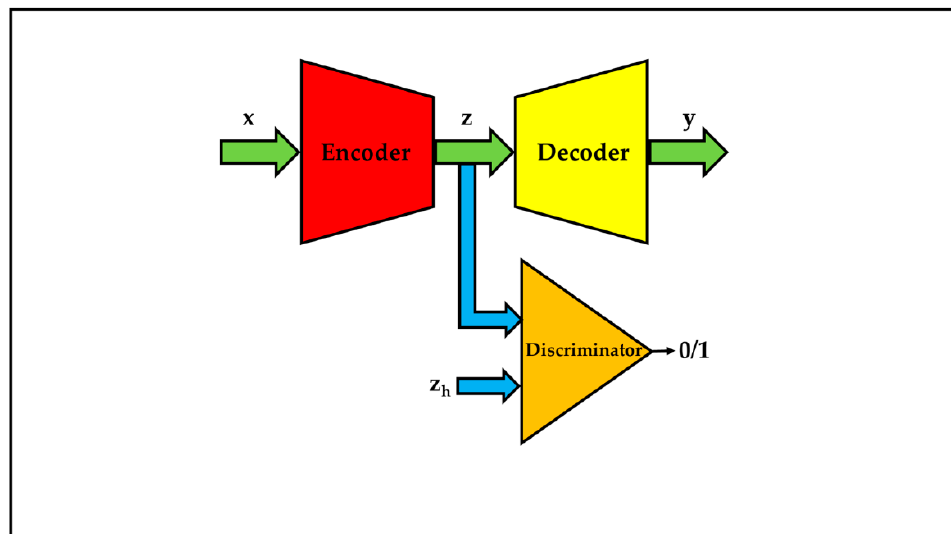
Figure 7. The architecture of classical adversarial auto-encoders.